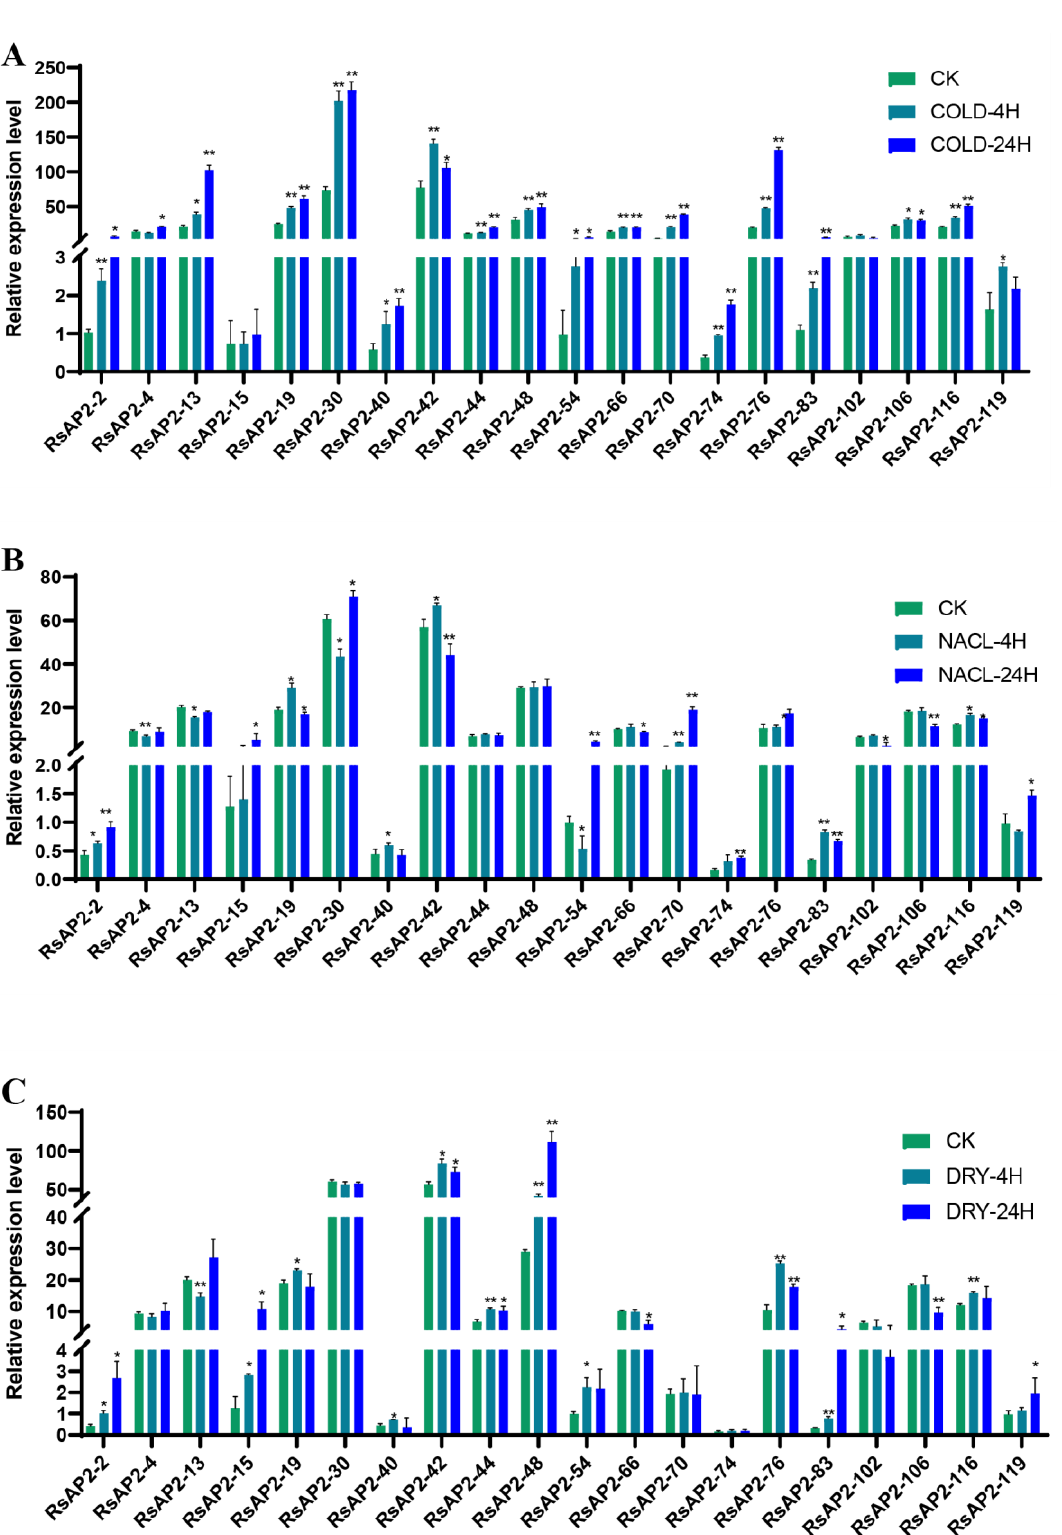
Figure 9. Relative expression level of 20 selected RsAP2 genes in response to cold ( A ), salt ( B ) and drought ( C ) treatments. Actin gene was taken as the internal reference gene. The relative expression levels are presented with mean and standard deviation of qRT-PCR. The significance test is presented with asterisks: * p < 0.05, ** p < 0.01, Student’s t -test.